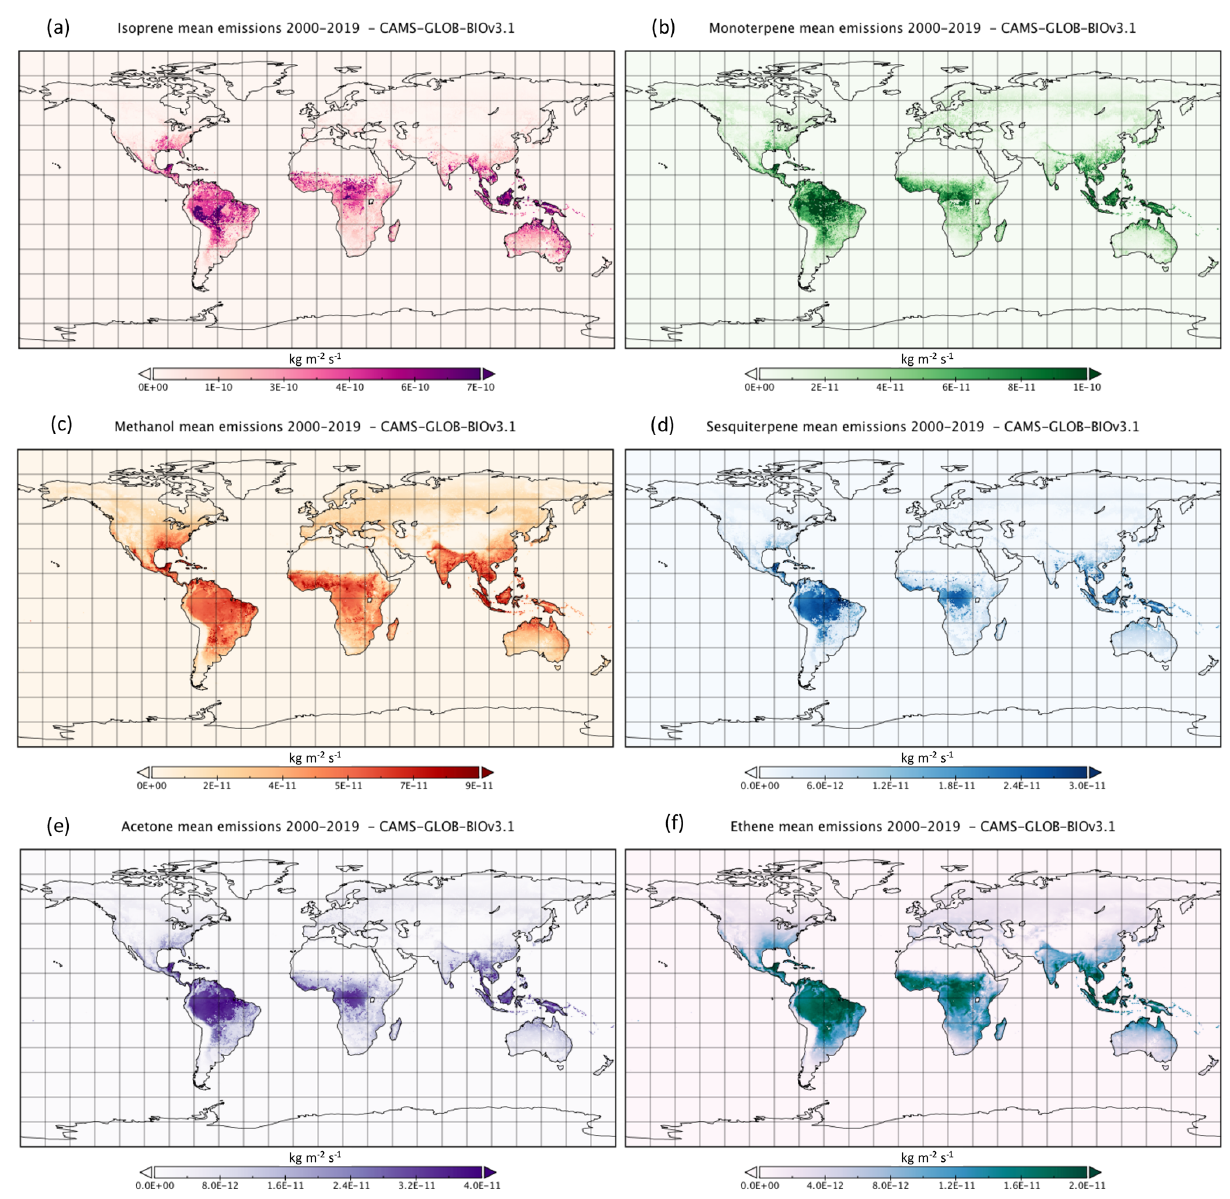
Figure 1. Spatial distribution of emissions averaged over the 2000–2019 period for (a) isoprene, (b) sum of monoterpenes, (c) methanol, (d) sum of sesquiterpenes, (e) acetone and (f) ethene in the CAMS-GLOB-BIOv3.1